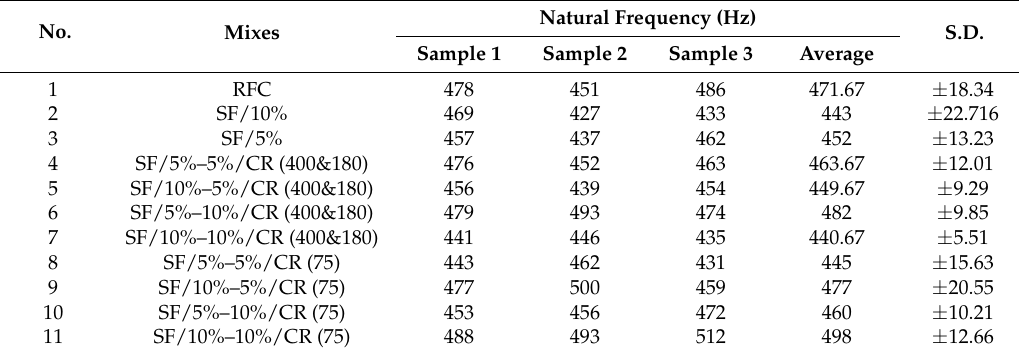
Table 5. Types of moulds and corresponding tests.